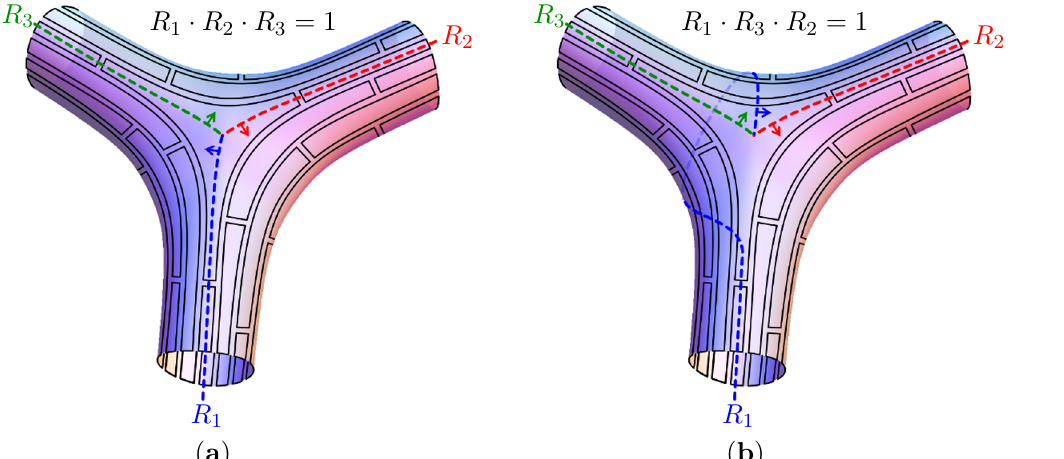
Figure 4 . Two di(cid:11)erent ordering of twist transformations that can contribute to the correlator of three twisted operators with twists R 1 , R 2 and R 3 . For a given ordering (cid:27) to contribute, the three twist transformations have to satisfy the monodromy condition R